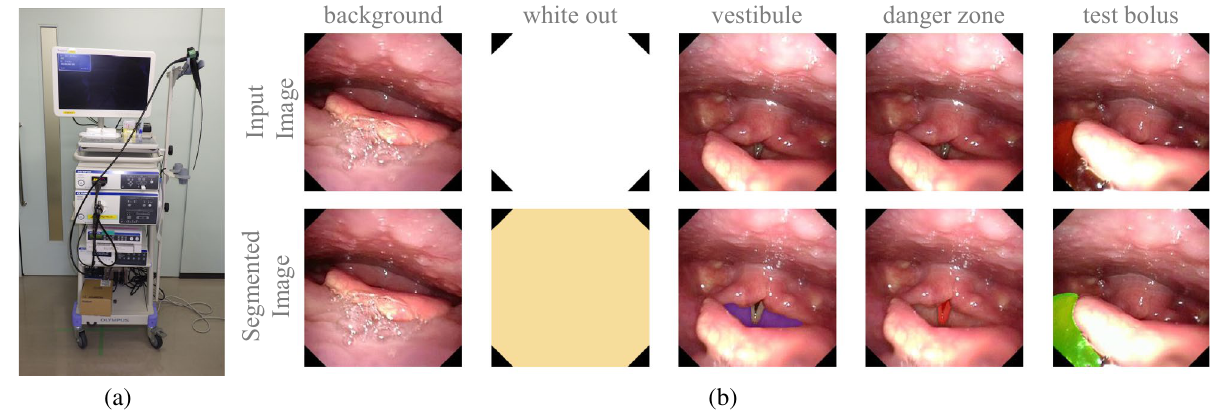
Figure 2. FEES was performed using ( a ) a laryngeal flexible endoscope with a diameter of 2.6 mm (ENF-V3, O, OLYMPUS Corp., Tokyo, Japan). ( b ) From left to right: image only with background,“white-out”, penetration area, aspiration area, and test bolus.